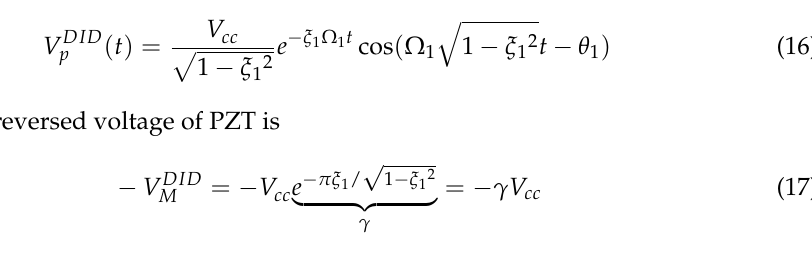
p c i ′ Figure 11. Driving process of the DID circuit, including four stages ( a – d ) in a cycle. In Figure 11b, when switch O1 is turned on, the inductor current ′ p c i is increased. Ac- cording to Equation (11)–(15), its voltage can be expressed as ( )